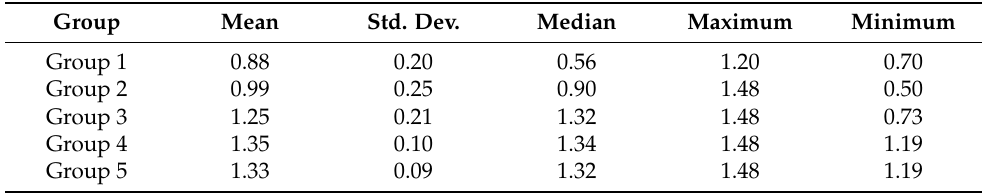
Table 6. Total emissions per inhabitant, in tCO 2